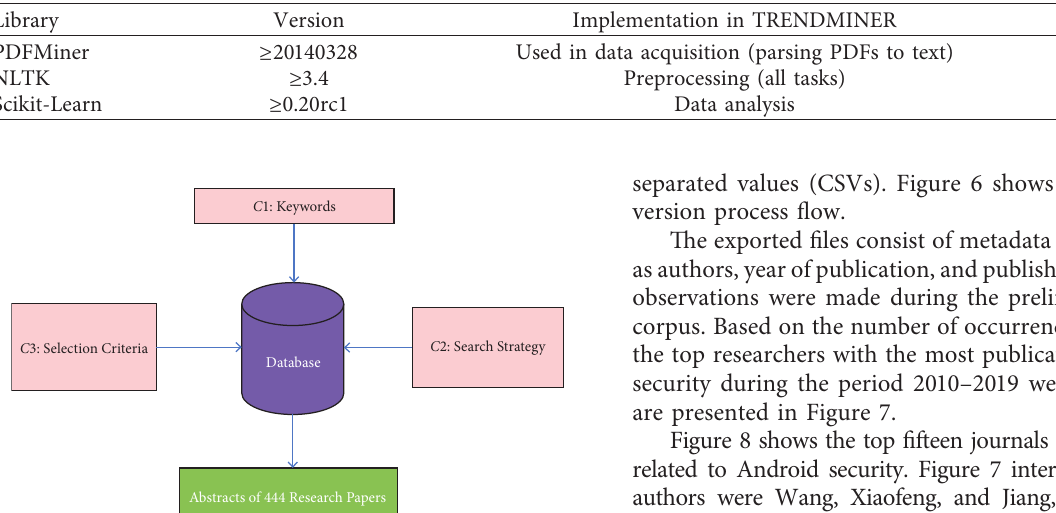
Table 2: Software specifications.